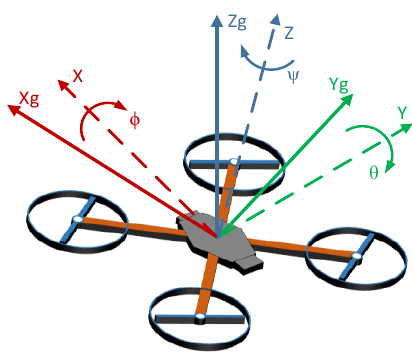
Figure 1. The representation of quadcopter attitude.